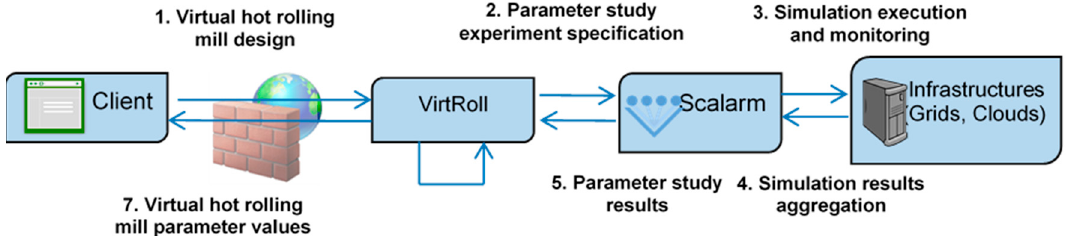
Figure 1. An overview of a system-supporting study on the workflow of the hot strip rolling processes.